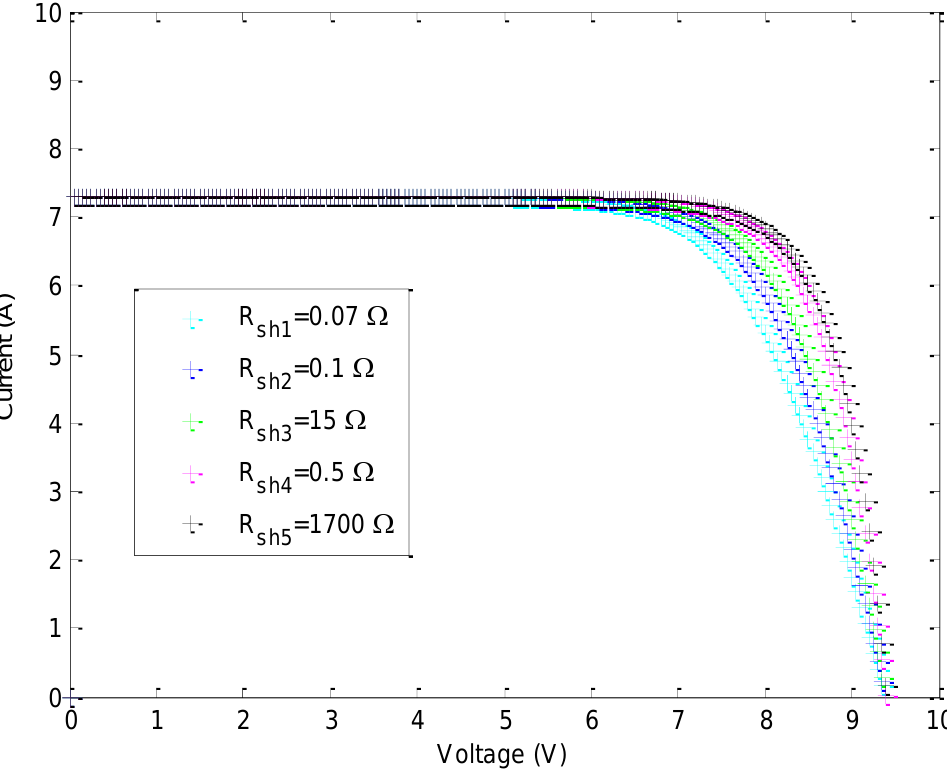
Figure 4. I-V characteristic curves for parametric variation of shunt